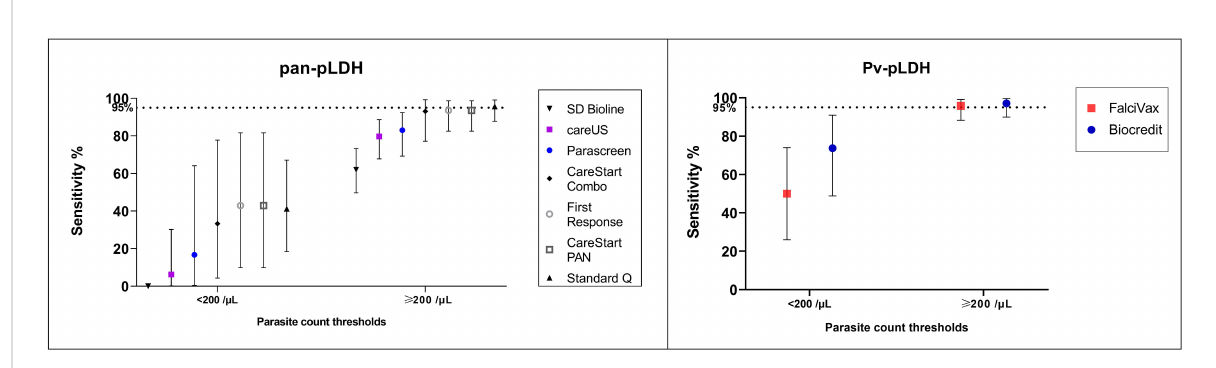
FIGURE 1 Sensitivity (and 95% con fi dence intervals) of (left) pan-pLDH and (right) Pv-LDH in detecting P. knowlesi for parasite count groups of <200/µL and ≥